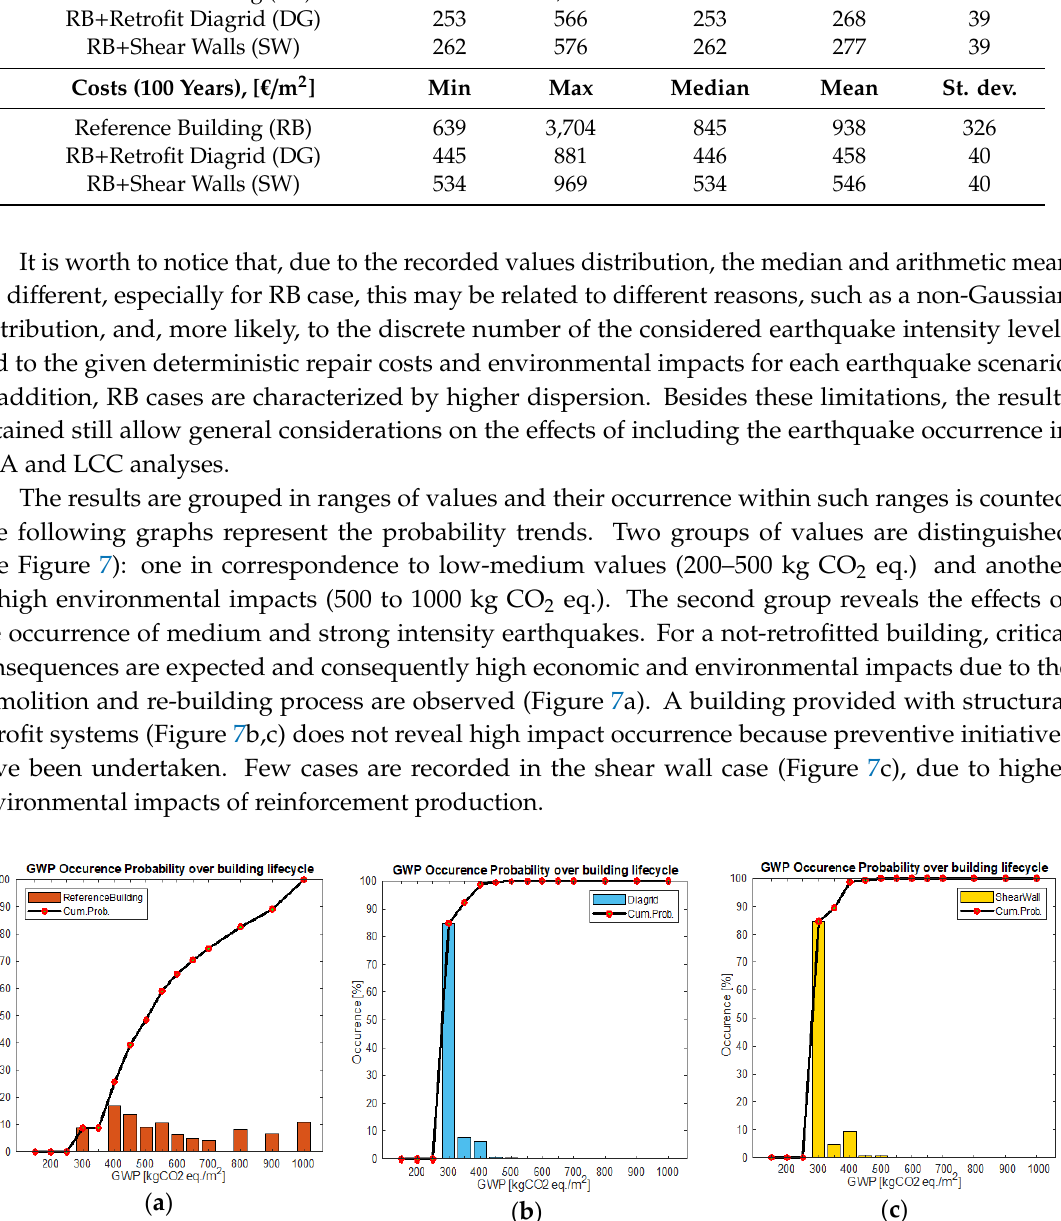
( c ) Figure 8. Cost occurrence probability for ( a ) non-retrofitted reference building, retrofitted building with ( b ) diagrid and ( c ) shear walls.